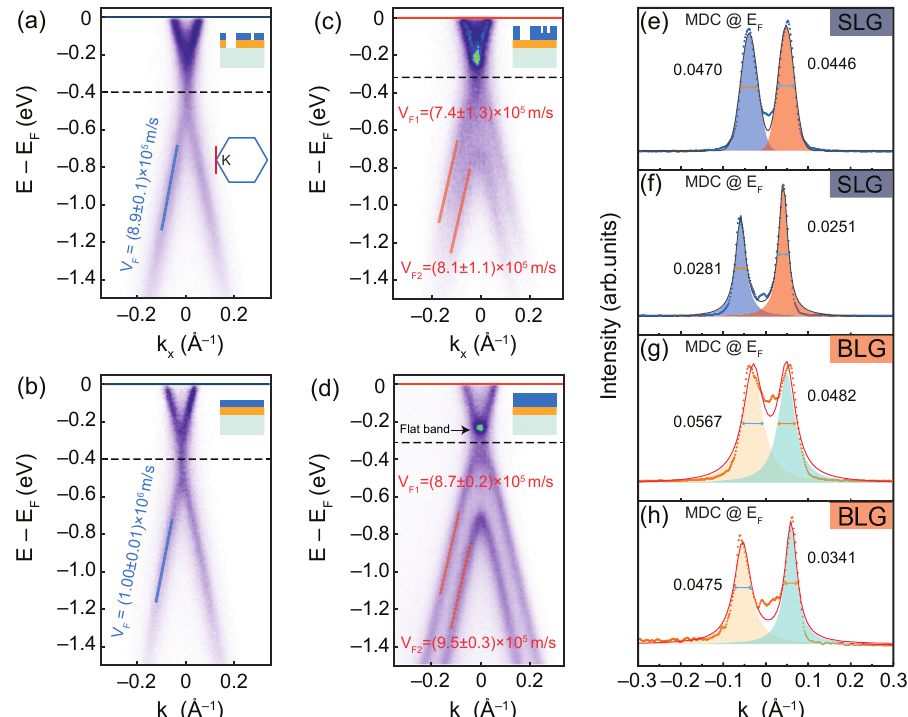
Figure 3. Band dispersion spectra of π bands around the K point of the Brillouin zone (see red line in the inset) via the ARPES spectra of epitaxial graphene on 4H-SiC(0001) and the linear fitting results of ( a ) SLG without nitrogen plasma treatment, ( b ) SLG with nitrogen plasma treatment, ( c ) BLG without nitrogen plasma treatment, and ( d ) BLG with nitrogen plasma treatment, respectively. The positions of Dirac points in panel ( a – d ) are marked with black dashed lines. The flat band is pointed out with a black arrow in panel ( d ). The Fermi velocities with the error of 95% confidence bounds are also marked in the panels ( a – d ). ( e – h ) MDCs measured along the Fermi level corresponding to the panels ( a – d ), the FWHM is marked on each